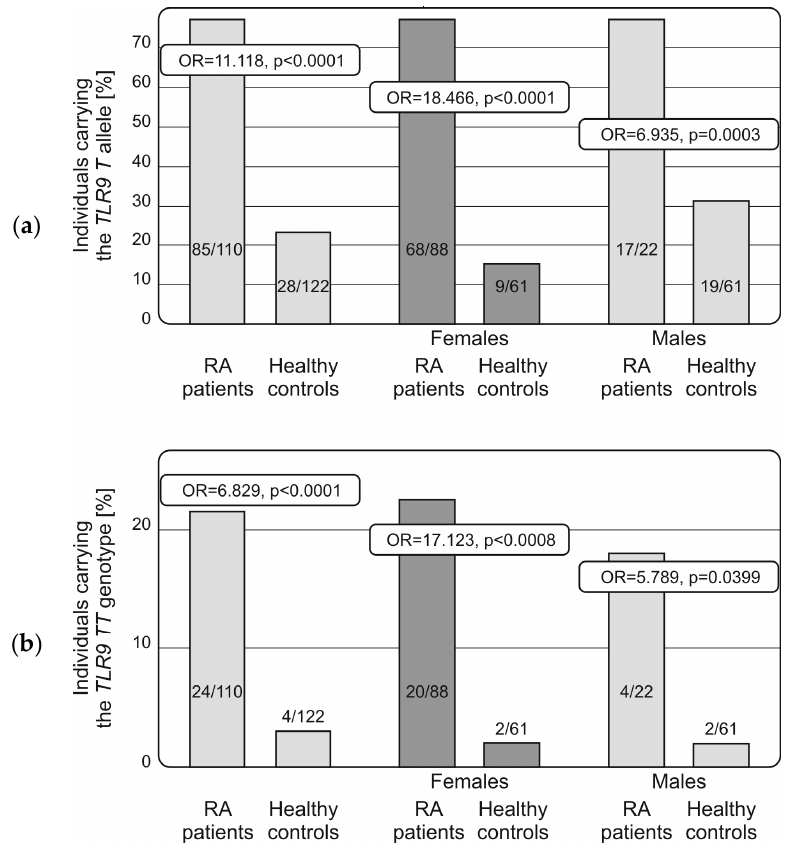
Figure 1. Distribution of the TLR9 (rs187084) T allele ( a ) and TT homozygous genotype ( b ) in female and male patients with rheumatoid arthritis and healthy individuals. The presence of the T allele and its homozygosity was found to be associated with predisposition to the disease in females and males. There were no significant differences in the distribution of the NF- κ B1 (rs28362491; − 94 ins/del ATTG), TLR2 (rs201786064, − 196/ − 174 del/ins) and TLR4 (rs4986790; Asp299Gly, 13,843 A > G; and rs4986791, Thr399Ile, 14,143 C > T) alleles and genotypes between the groups of RA patients and healthy controls (Table 2). The analyzed non-synonymous TLR4 polymorphisms were in strong linkage disequilibrium in both patients and healthy individuals. The TLR4 rs4986790 A allele was detected together with the C allele of the TLR4 rs4986791 and, in an analogous manner, the G